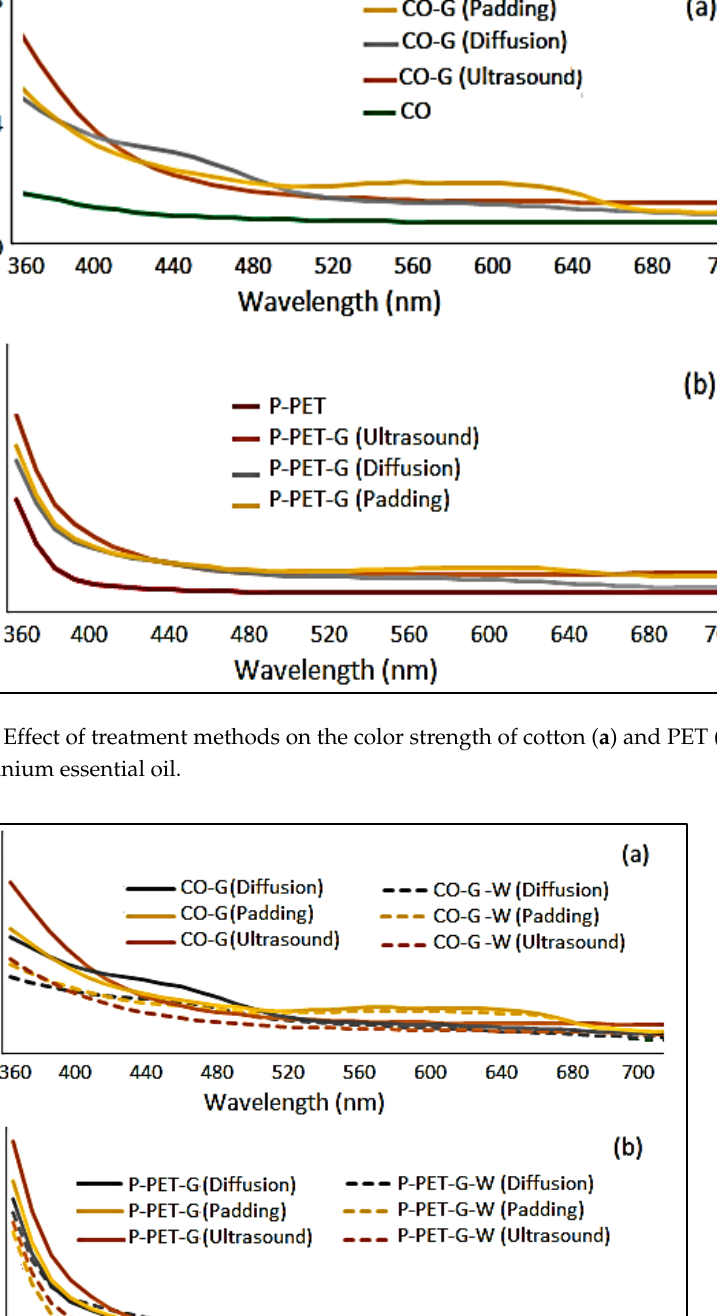
13 of 21 Figure 7. Comparison of olfactory stimulation effects on the treatment methods. 3.6. Color Strength Evidence of EO Absorption into Fabrics In this study, the measurements of color strength were employed to show not only the successful absorption of geranium oil into polyester and cotton fabrics, but also to compare and evaluate the treatment methods [35]. In order to deduce the correct conclu- sion, the measurement was carried out under normal condition for all samples. Effects of ultrasound, diffusion, and padding treatments on the color strength of fabrics are shown in Figure 8. It is shown that the color strength of both fabrics was higher for the data of the ultrasound, which present 0.91 vs. 0.81 and 0.77 on the P — PET — G and 0.79 vs. 0.56 and 0.50 on the CO — G treated via padding and diffusion methods, respectively. The high- est color strength (0.91) was shown in the fabric treated by ultrasound, whereas the lowest color strength (0.50) was obtained by the fabric treated via the diffusion process. Conse- quently, it can be assumed that GEO were absorbed into the polyester and cotton fiber via the used treatments process, particularly the ultrasound which significantly showed the incorporation of GEO. The achieved results are consistent with those obtained by SEM,